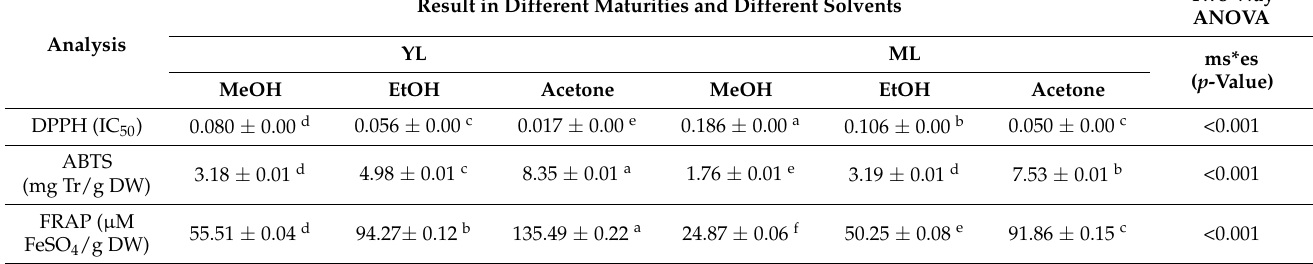
Table 4. The antioxidant activity of mulberry leaves. The results of two-way ANOVA are shown for the interaction of the two factors: maturation stages (ms) and extraction solvent